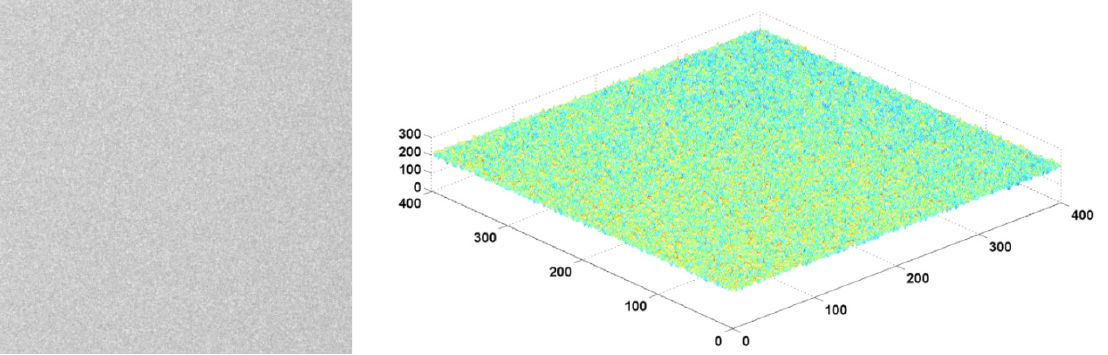
Figure 8. A laser illumination image (left) with the speckle contrast of 4.1% and 3D intensity distribution (right) based on a speckle-suppressed 1000/2200 multi-mode plastic fiber.